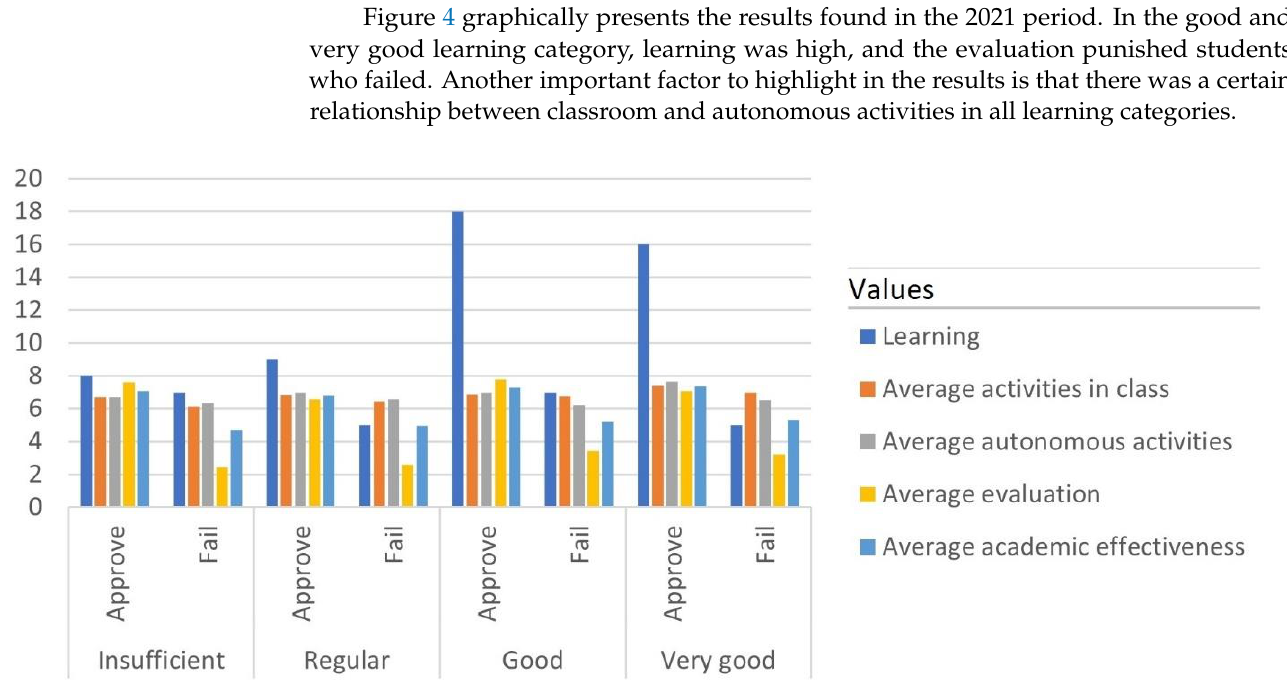
Table 17. Analysis of the data obtained from the 2022 period with the establishment of the categories of learning and academic effectiveness.